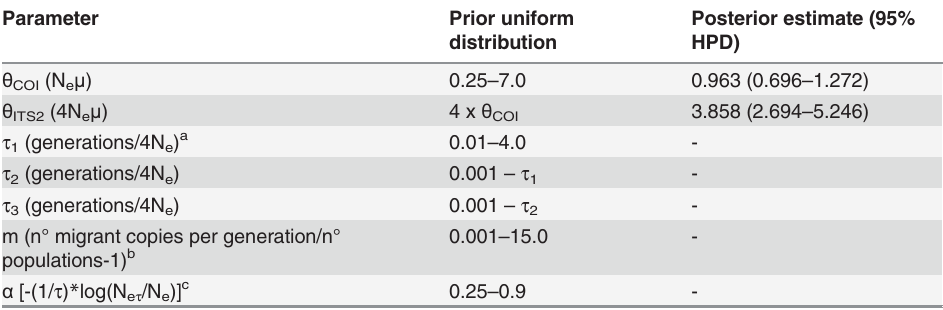
Table 1. Prior distributions of parameters and posterior estimates based on the most probable